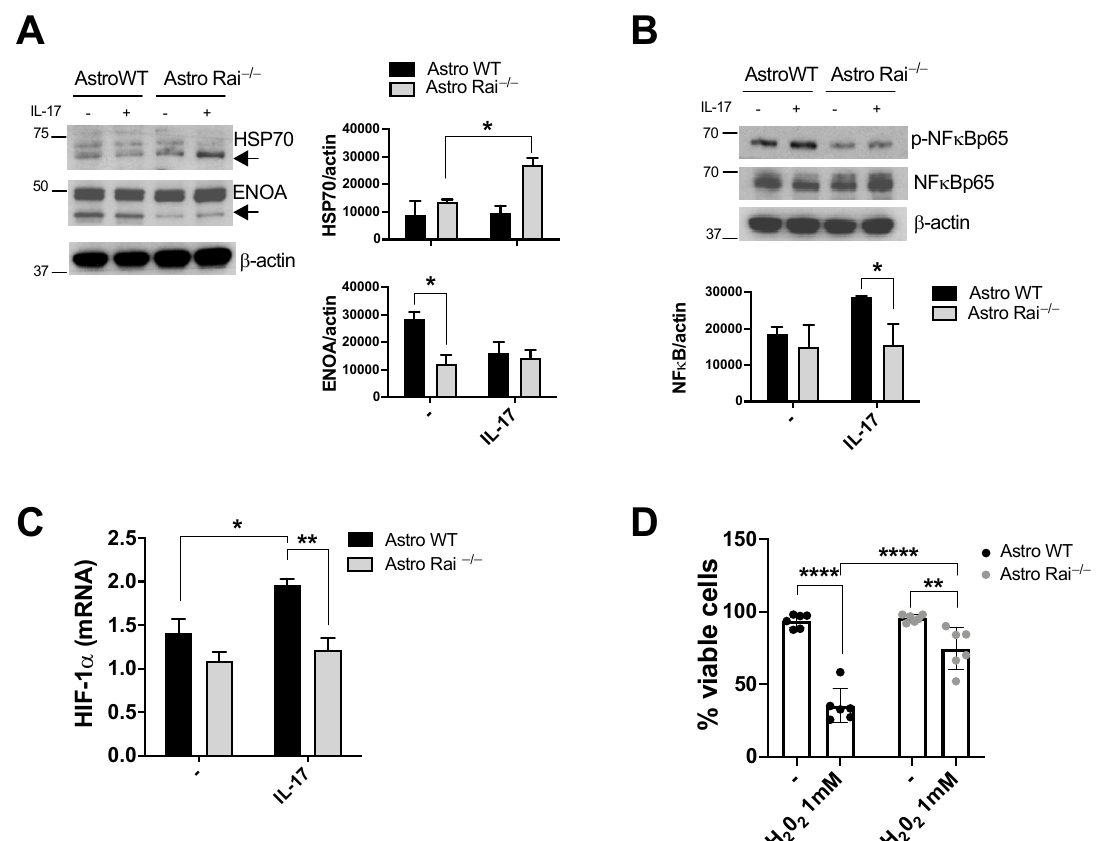
Figure 5. Rai supports the IL-17-dependent neuroinflammatory response in astrocytes through the activation of NFκB- HIF-1α pathway and the inhibition of HSP70 upregulation. ( A ) Immunoblot analysis of HSP70 and ENOA in lysates of WT (Astro WT) and Rai −/− (Astro Rai −/− ) astrocytes untreated or treated with IL-17 (50 ng/mL) for 24 h; ( B ) Immunoblot analysis of phosphorylated and total NF-κB in lysates of WT (Astro WT) and Rai −/− (Astro Rai −/− ) astrocytes treated with IL-17 for 15 min at 37 °C or left untreated. Histograms showed in ( A ) and ( B ) represent the quantification by densitometric analysis of the levels of the indicated proteins relative to actin ( n = 3); ( C ) qRT-PCR analysis of HIF-1α transcripts in WT (Astro WT) and Rai −/− (Astro Rai −/− ,) astrocytes treated as in ( A ). Data are presented as mean value ± SD ( n = 3); ( D ) Flow cytometric analysis of WT (Astro WT) and Rai −/− (Astro Rai −/− ,) astrocytes treated with 1 mM H 2 O 2 for 24 h at 37 °C and stained with PI immediately before the acquisition. The graph shows the mean value ± SD of the percentage of PI negative cells (viable cells) ( n = 6). **** p < 0.0001, ** p < 0.01, * p < 0.05.